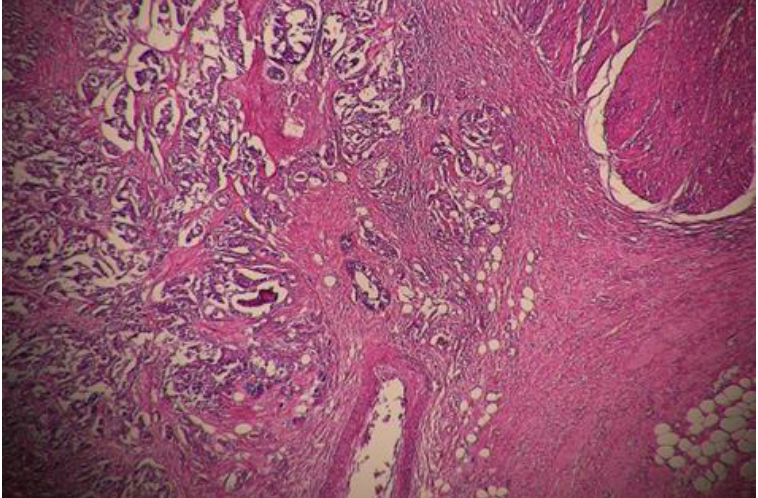
Figure 5. Poor pathological response (TRG3); x 40 HE; Widespread of residual cancer. Table 2. Postoperative survival and surgery data according to TRG score.